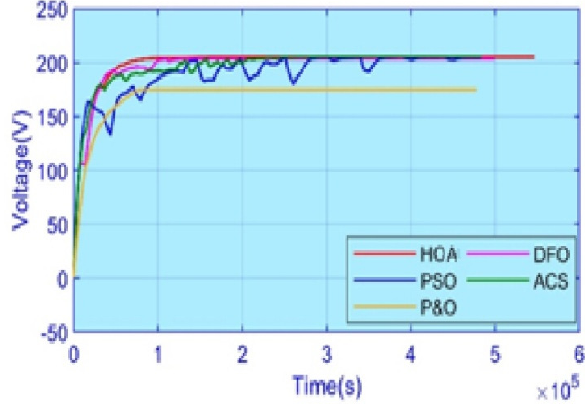
Figure 19. Comparison of the HOA power for Case 3 .